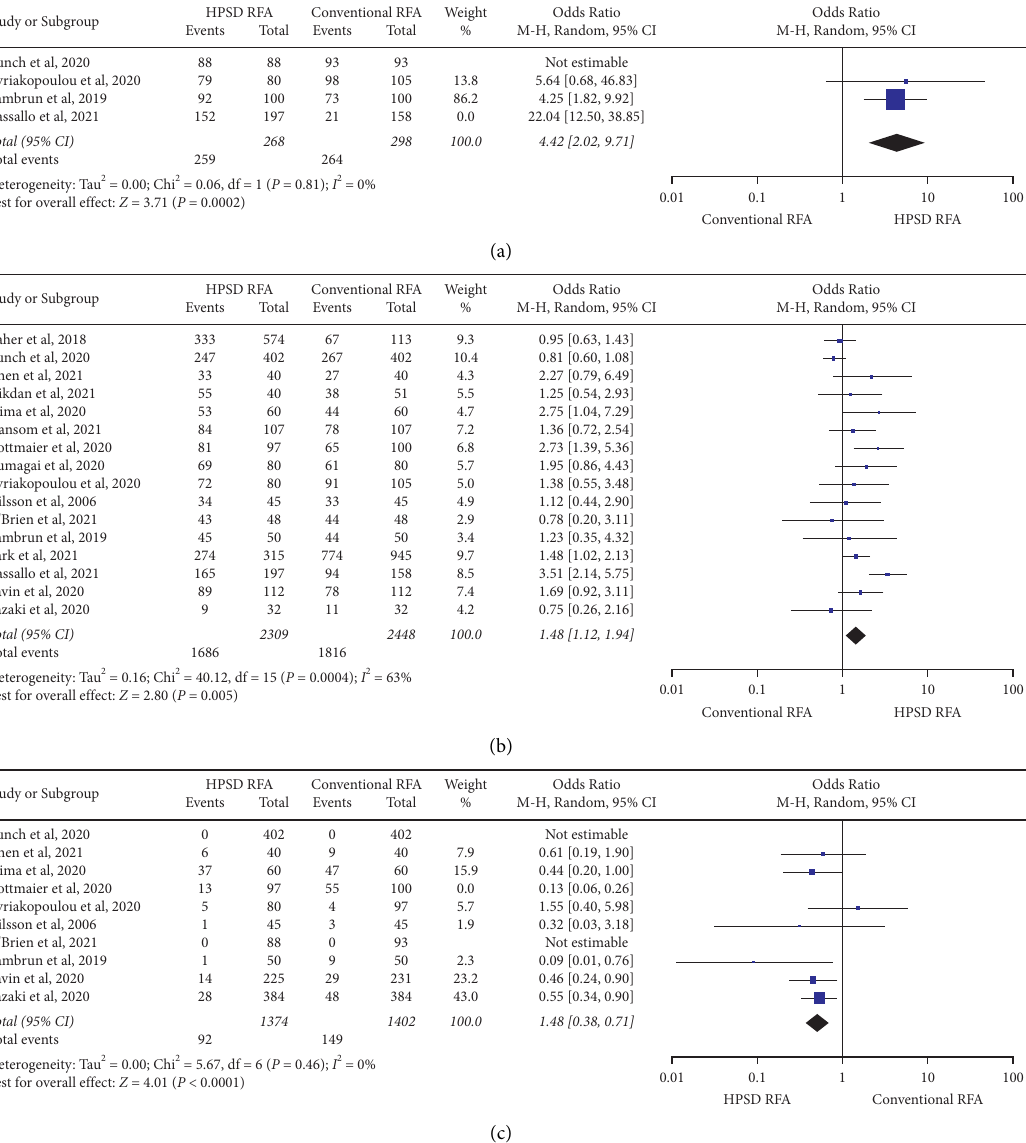
Figure 3: Forest plots of the primary pooled analysis demonstrating the effect of high-power short-duration RFA vs. conventional RFA in patients with atrial fibrillation. Data are events in each group and weighted odds ratios. )e horizontal line is the 95% CI. )e diamond shape is the pooled mean difference of all studies. CI: confidence interval; RFA: radiofrequency ablation, PVR: pulmonary vein reconnection. (a) First-pass isolation, (b) freedom from atrial arrhythmia at one year, and (c) acute